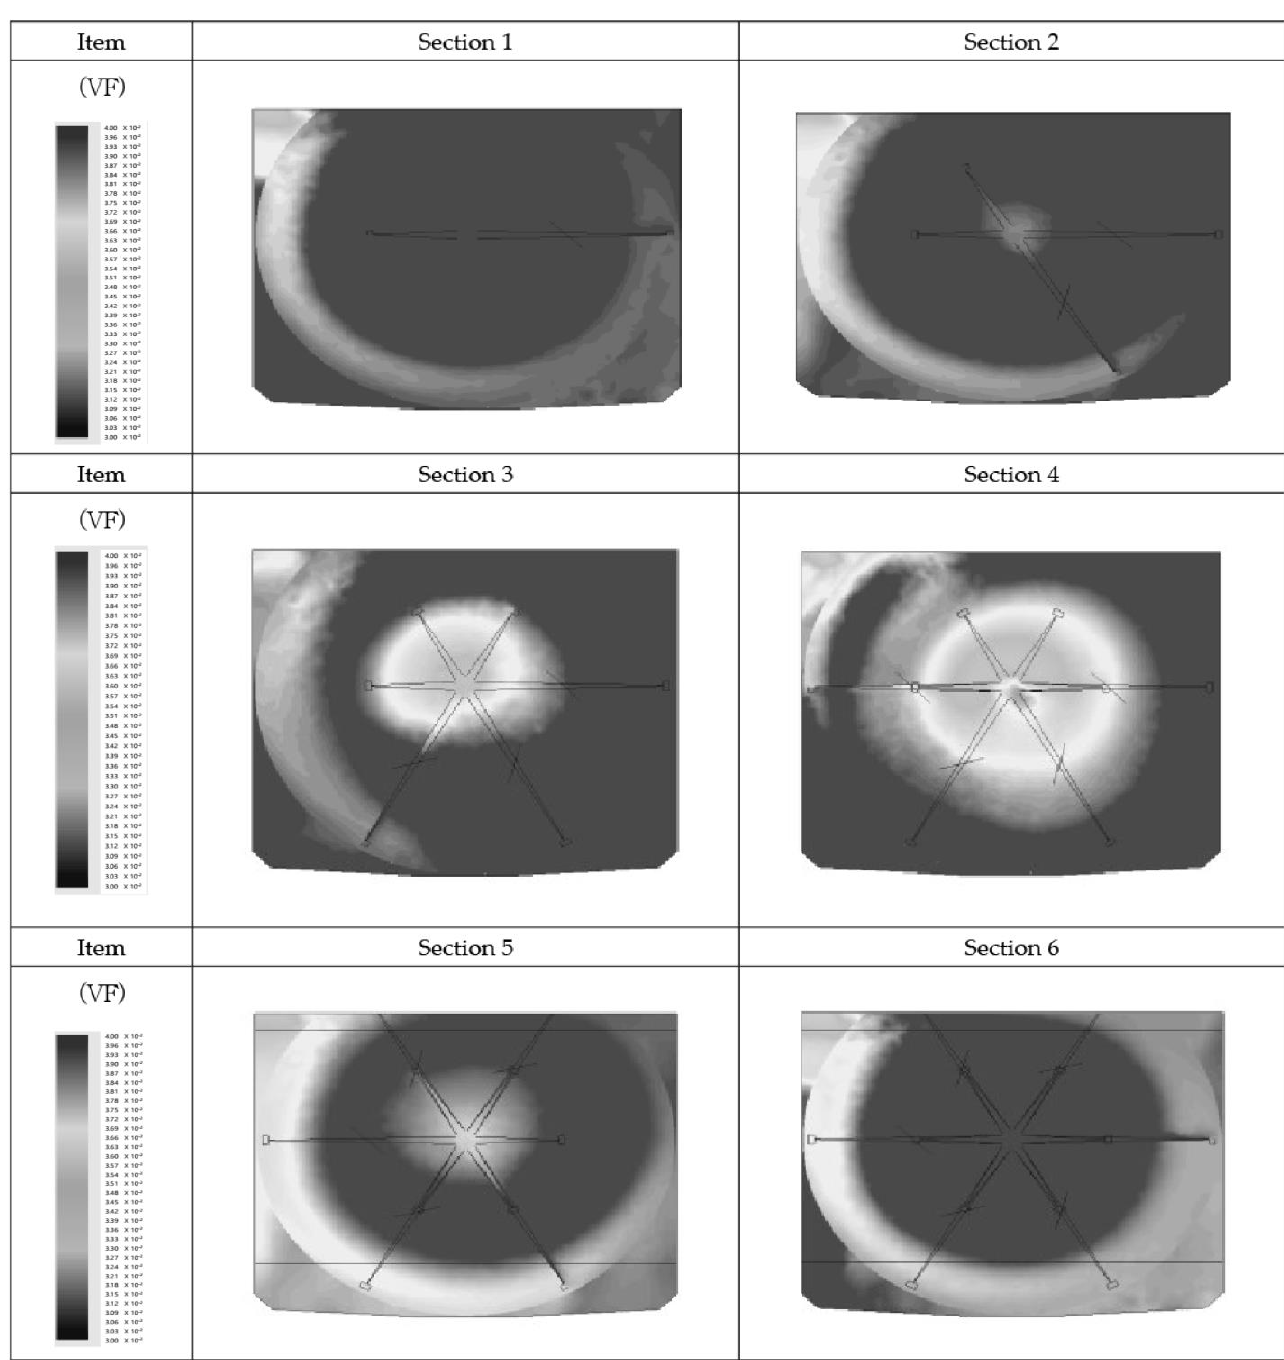
Figure A2. Concentration distribution as per the CFD simulation.